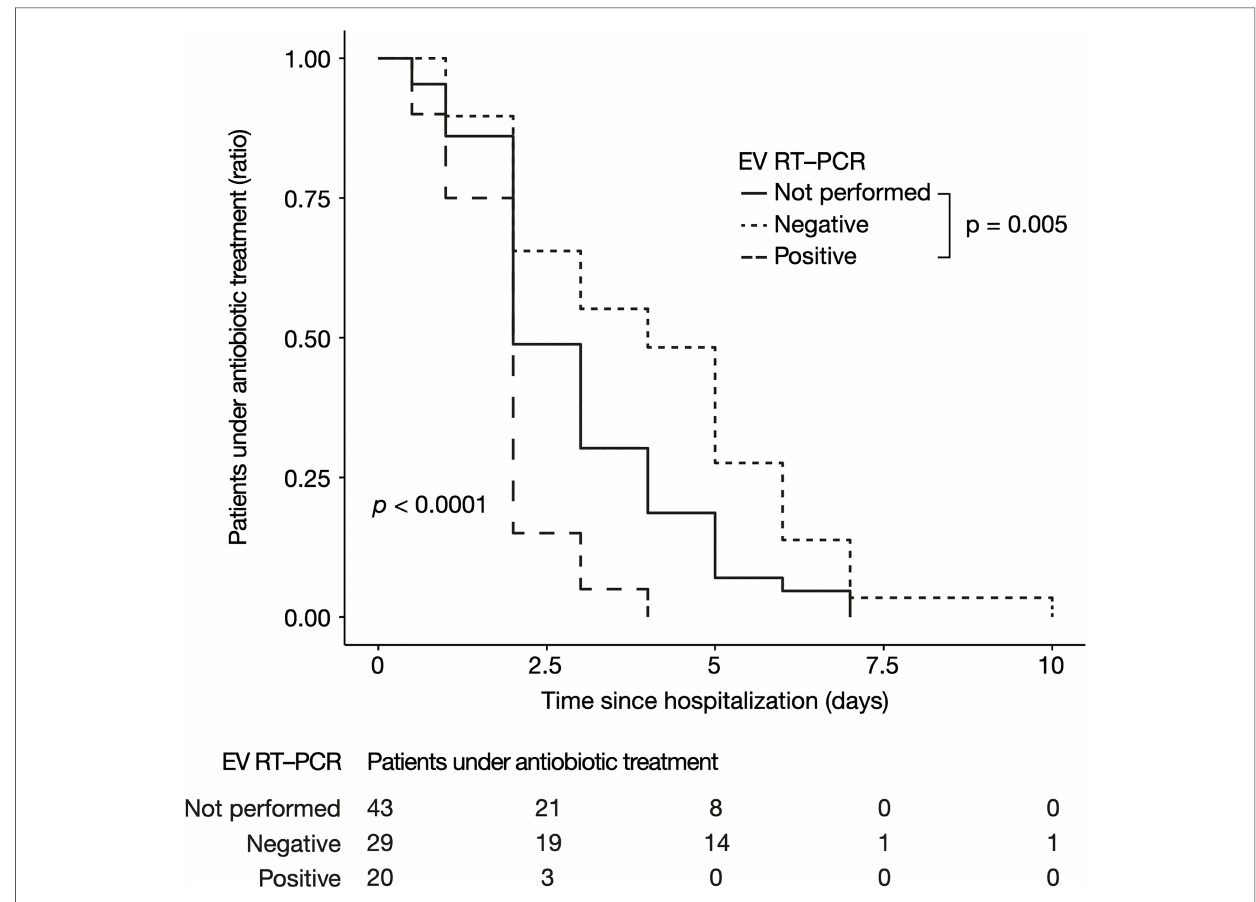
FIGURE 2 Antibiotic treatment duration according to EV RT-PCR status in children without pleocytosis. Represented as a Kaplan-Meier curve. The p -value was calculated by the log-rank test. EV, enterovirus; RT-PCR, reverse transcriptase polymerase chain